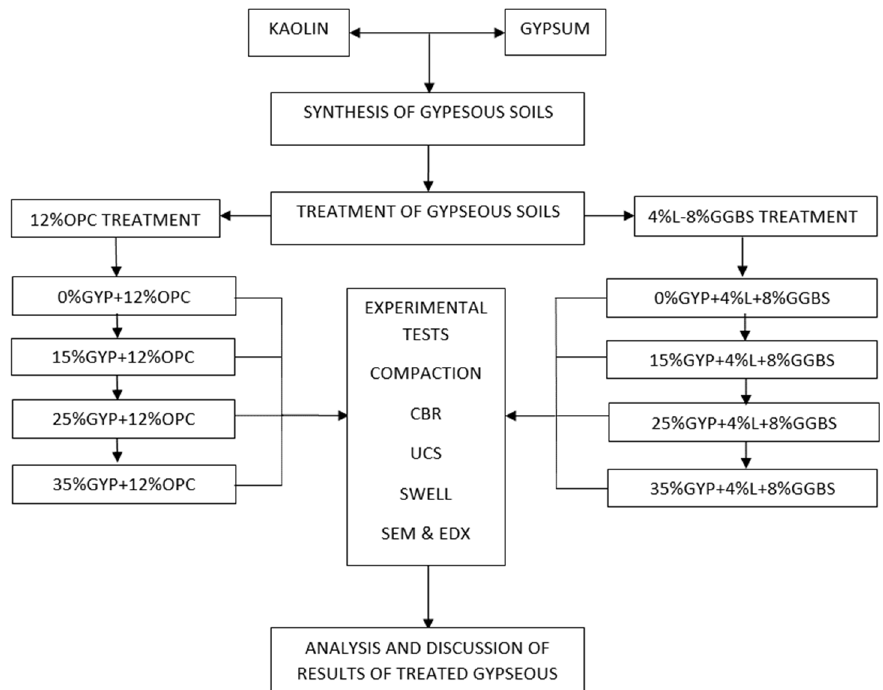
Figure 2. Experimental flowchart.